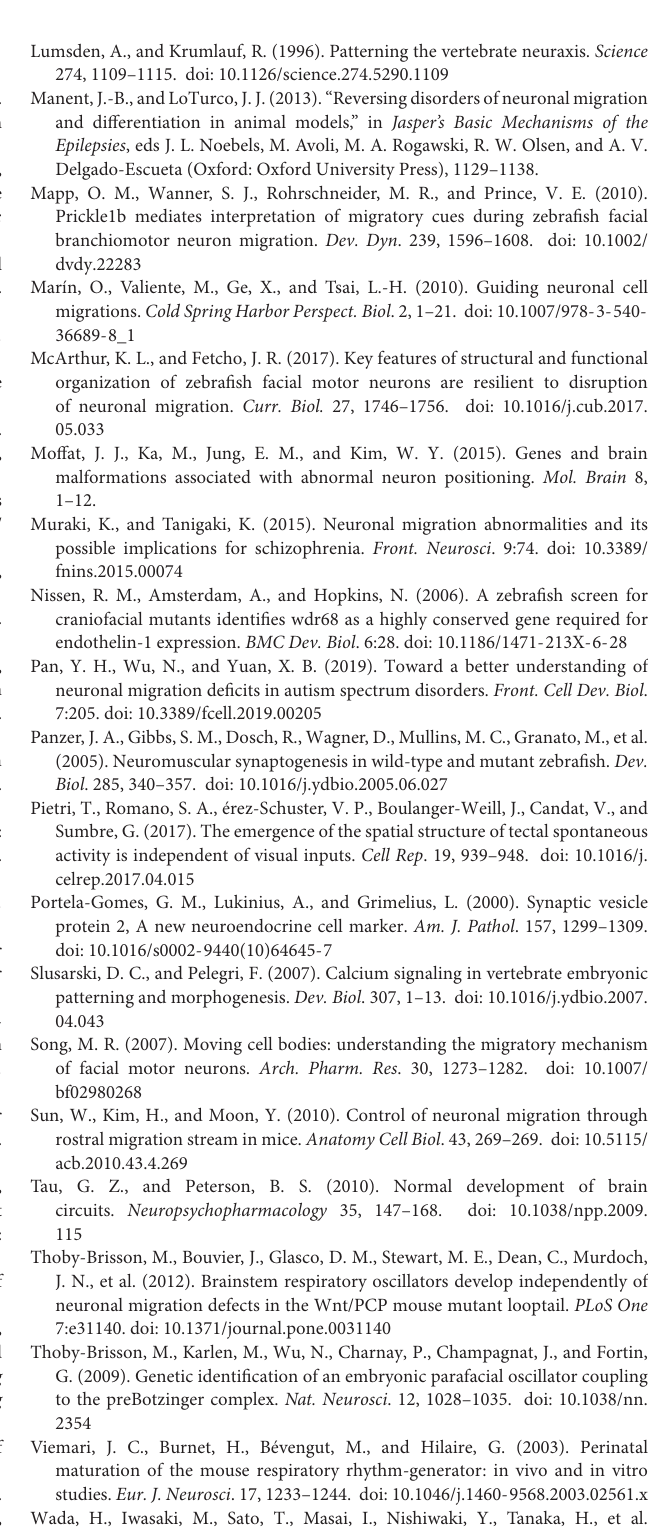
Supplementary Movie 8 | Dorsal view of the hindbrain of a 7 dpf olt mutant. Images of changes in Ca 2 + levels in branchiomotor neurons were obtained in the GFP channel at 2 frames per second for 5 min. Speeded up 12.5 ×